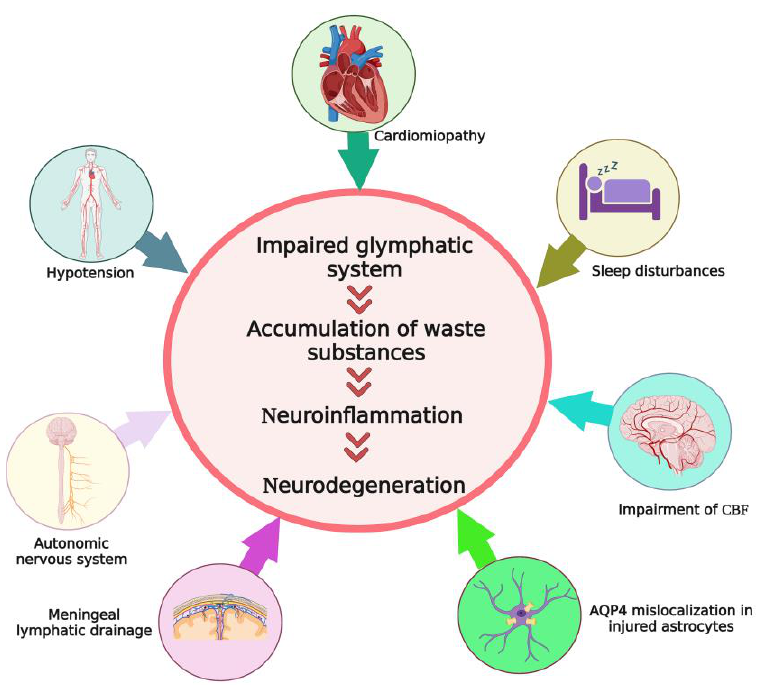
Figure 3. Schematic representations of some pathological processes which may affect normal function of the glymphatic system following HE. All these factors can impair the function of the glymphatic system throughout the cerebral tissue. This induces accumulation of waste substances in the brain interstitial space and triggers neuroinflammation, resulting in neuronal injury and progression of hepatic encephalopathy. CBF: cerebral blood flow; HE: hepatic encephalopathy. Created with BioRender.com.